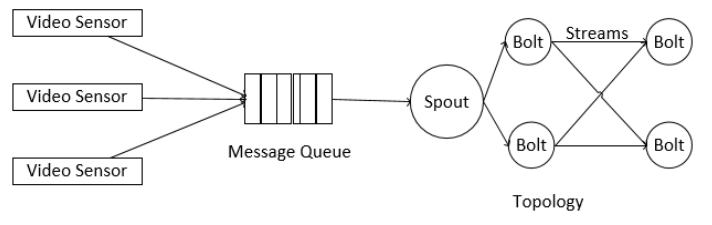
Figure 14. A general video processing system using